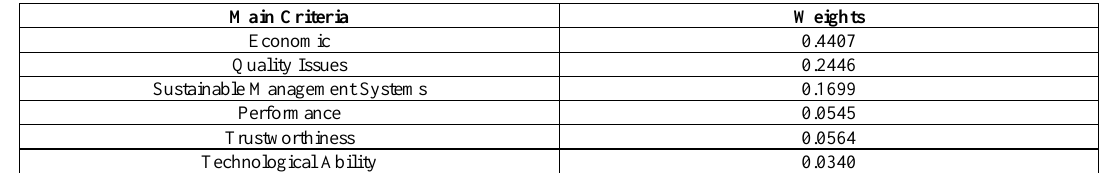
Table 2. Weights of main